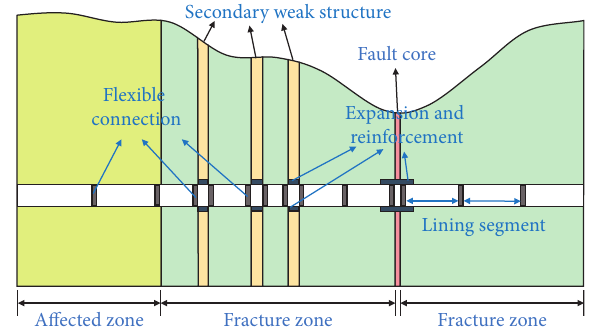
Figure 15: Engineering measures for tunnel crossing multilevel structural